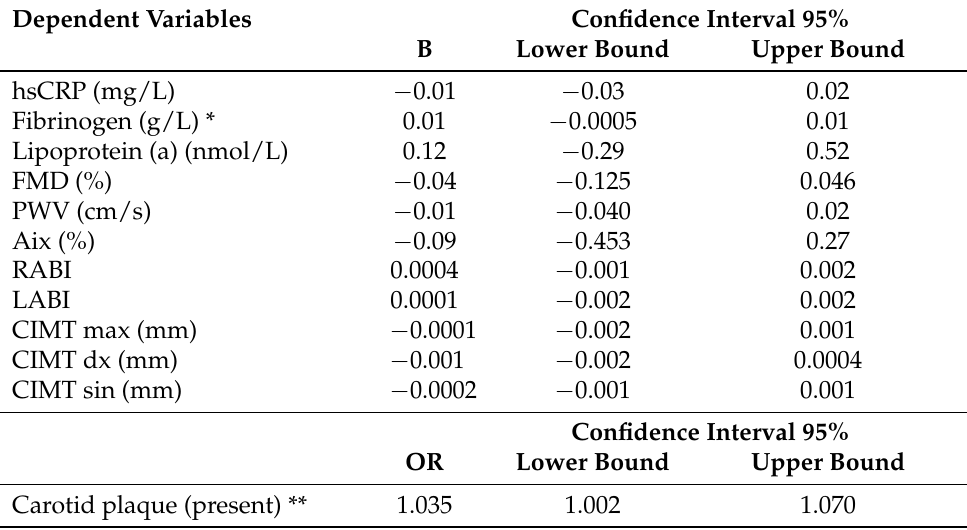
Table 4. Univariate (crude) effect of microalbuminuria level as predictor on markers of subclinical atherosclerosis (dependent variables), linear (B), and logistic (OR) regression coefficient and 95% confidence interval presented. Except for carotid plaque no statistically significant differences were